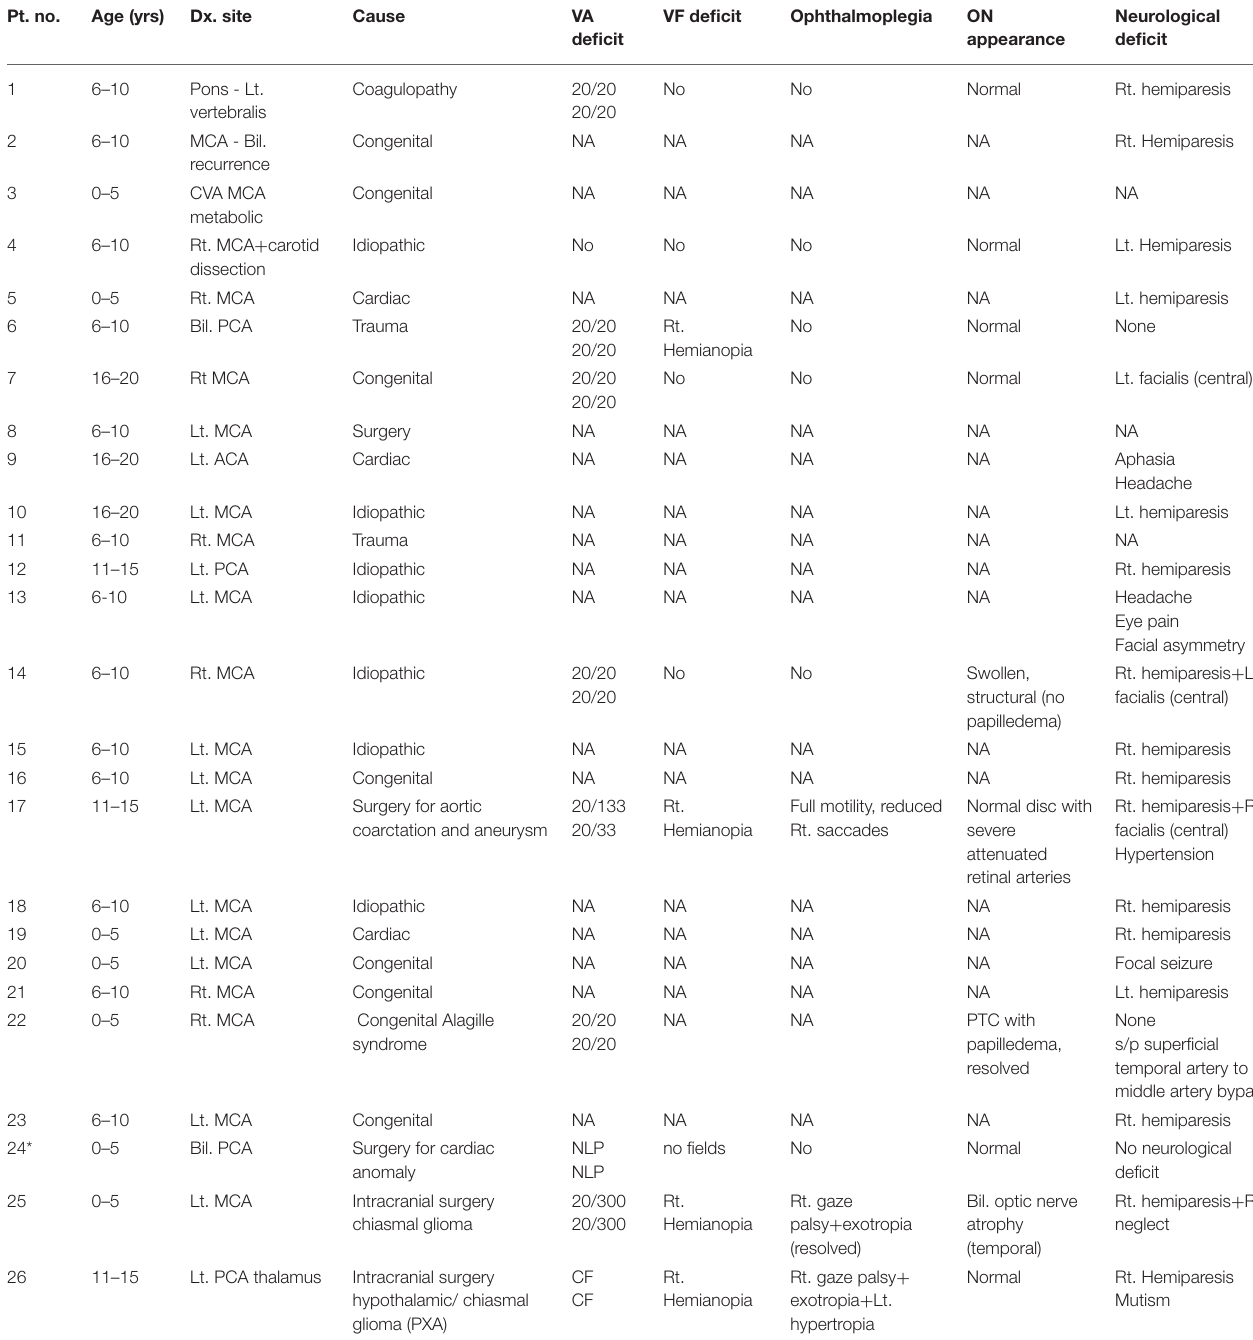
TABLE 1 | Data for 26 patients with cerebral arterial stroke. Pt.